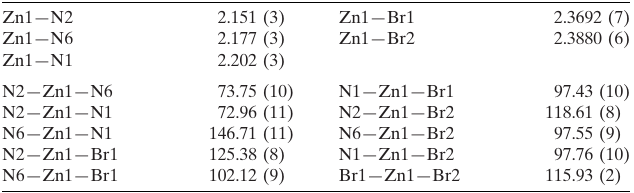
Selected geometric parameters (A˚ , (cid:2) ).